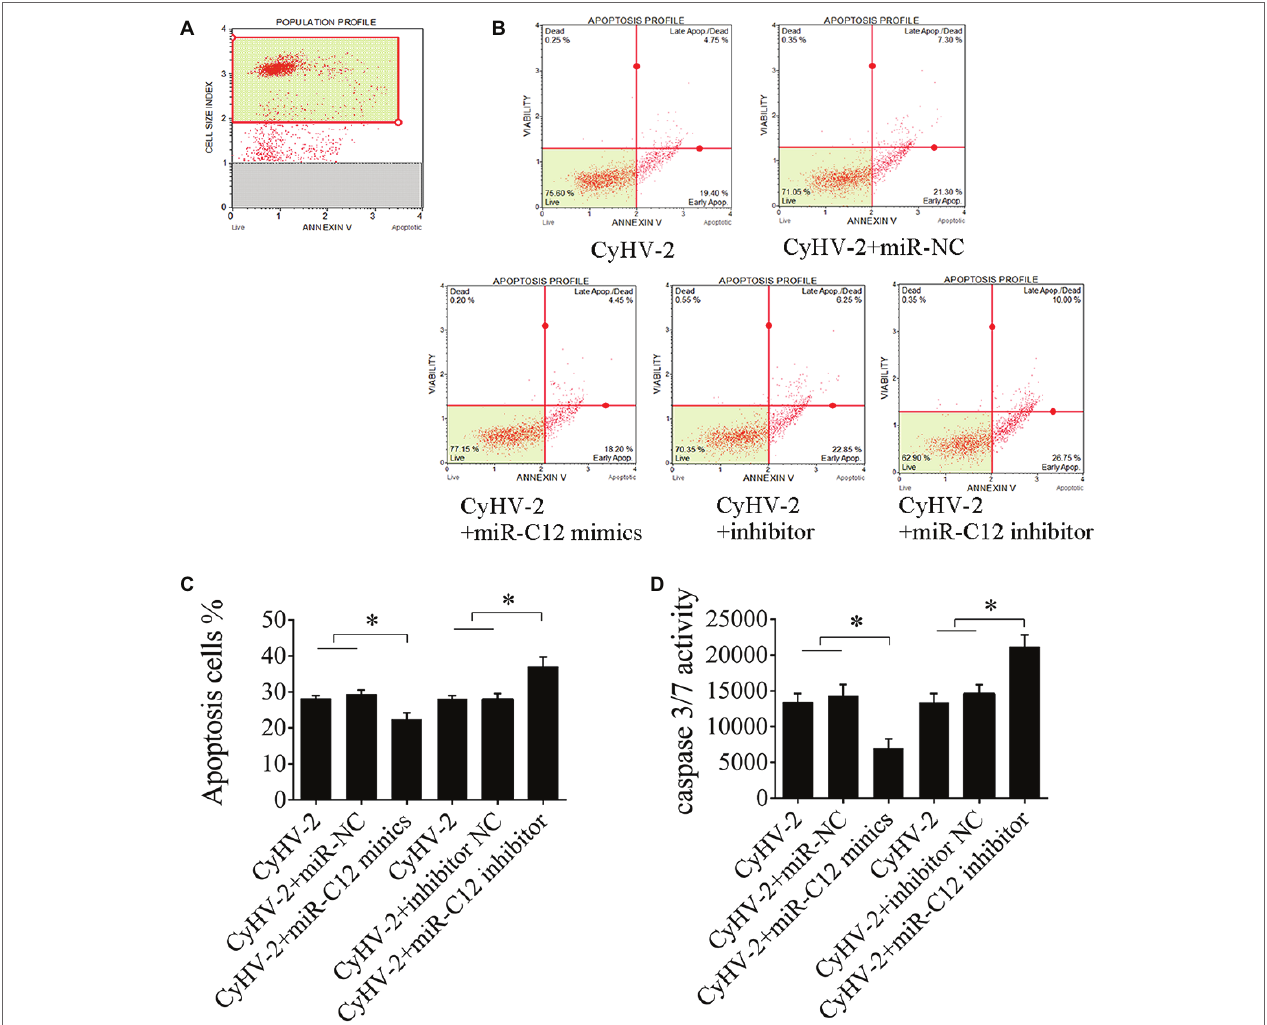
FIGURE 5 | Effect of miR-C12 on CyHV-2-mediated apoptosis. (A) Scatter plots of flow cytometry. miR-C12 was overexpressed or knocked down with the miR-C12 inhibitor in virus-infected GiCF cells. At 24 h post infection, apoptosis was assayed using annexin V analysis (B,C) and caspase 3/7 activity analysis (D) . Data represents the means ± SD from three independent experiments. ** p < 0.01; * p <